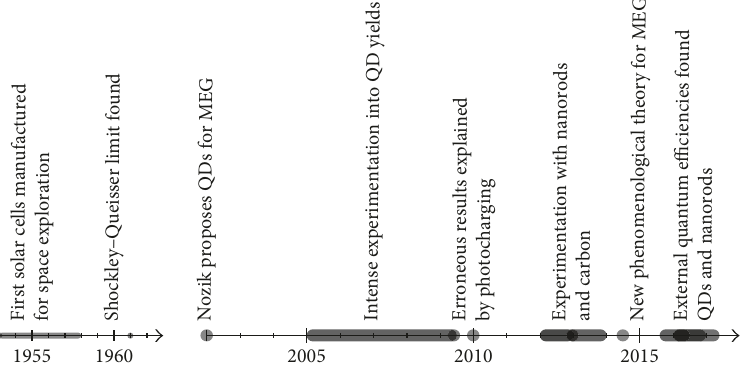
Figure 1: Timeline showing the main contributions to understanding and implementation of multiple exciton generation.